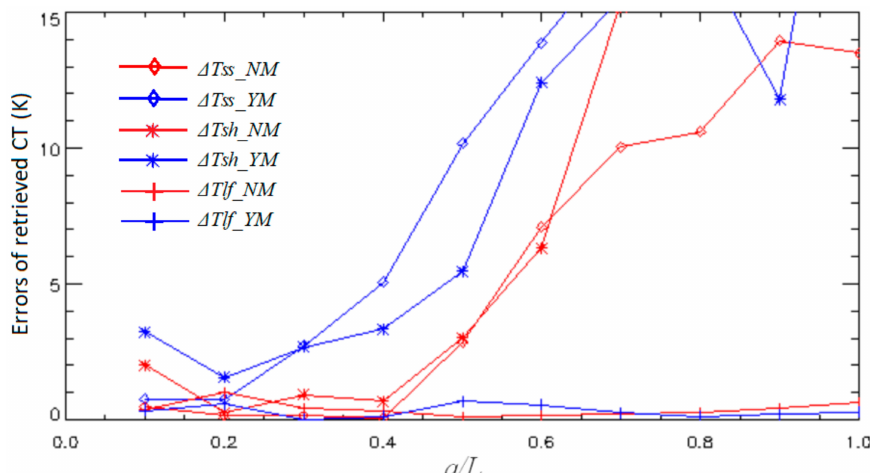
Figure 9. Errors of retrieved CT change with row structure configurations. ∆ Tss_NM and ∆ Tss_YM are errors of sunlit soil temperature inversion by the new model and by the Yu model, respectively. ∆ Tsh_NM and ∆ Tsh_YM are errors of shaded soil temperature inversion by the new model and by the Yu model, separately. ∆ Tlf_NM and ∆ Tlf_YM are errors of leaf temperature inversion by the new model and by the Yu model,